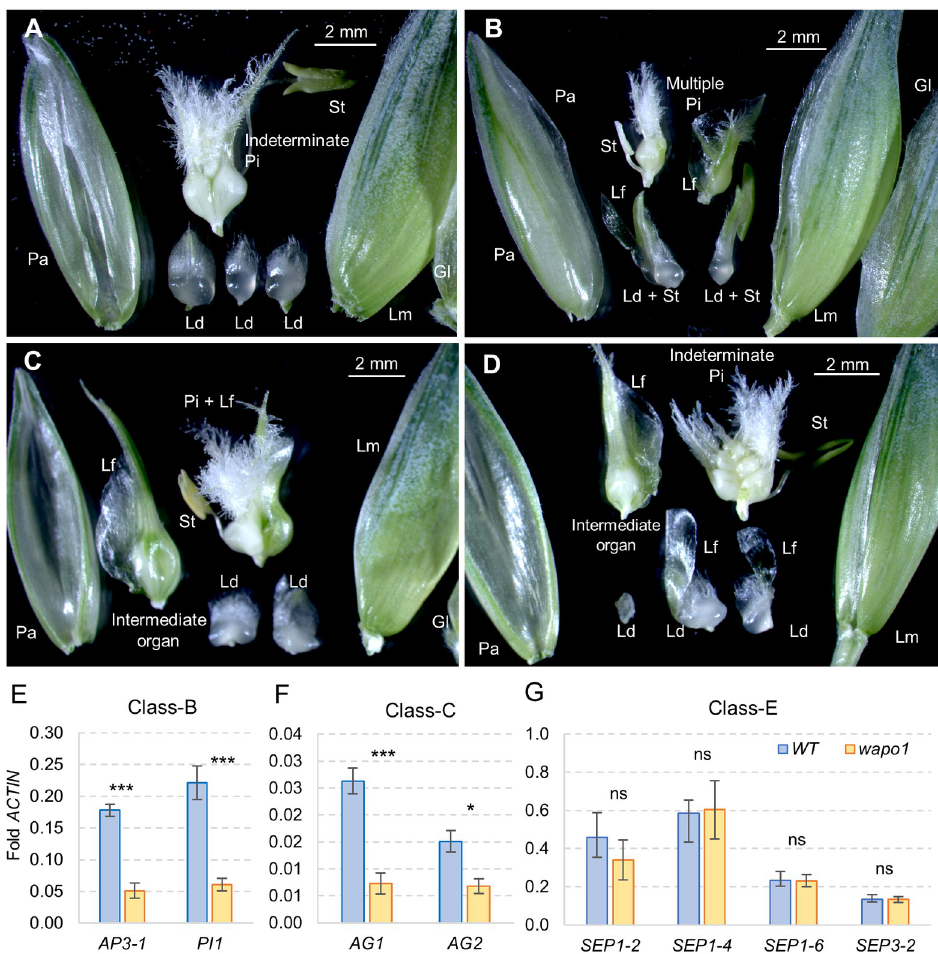
Fig 3. Floral abnormalities and expression profiles of Kronos wapo1 loss-of-function CRISPR mutant ( wapo-A1 wapo-B1 ). ( A ) Mutant T 1 -101, floret one from basal spikelet showing three lodicules, one stamen and two fused pistils. ( B ) Mutant T 1 -101, 2 nd floret from 3 rd most distal spikelet. Lodicules fused with stamens and leafy tissue. Indeterminate pistils fused with leafy tissue. ( C ) Mutant T 1 -13, 2 nd floret of basal spikelet. One lodicule fused with leafy tissue, and an intermediate organ fused with leafy tissue, and pistil fused with leafy tissue. ( D ) Mutant T 1 -13, 3 rd floret of basal spikelet. Lodicules with elongated leafy tissue, intermediate organ and indeterminate pistils. Lm = lemma, Pa = palea, Ld = lodicule, St = stamen, Pi = pistil, Lf = fused leafy tissue, + = fused organs. Frequency of the different floral abnormalities is available in Data C in S1 Data. A wild-type Kronos floret is shown in Fig 4 as reference. ( E-G ) Expression analysis of class-A, -B, -C and -E MADS-box genes in Kronos and wapo1 mutants (MADS-box gene nomenclature is based on [20]). Primers for the qRT-PCRs are listed in S1 Table. Bars represent averages of four replicates and error bars are s.e.m. Each replicate is a pool of 12 developing spikes at the stamen primordia stage (~W4.0 in Waddington scale). ns = not significant, � = P < 0.05, �� = P < 0.01, and ��� = P < 0.001. Data and statistical analyses used in E-G are available in Data D in S1